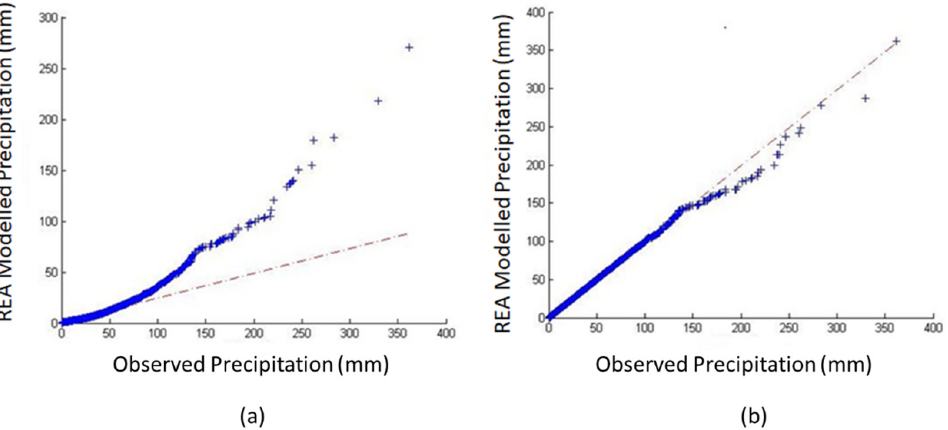
Figure 3. Quantile–Quantile (QQ) map of observed vs. REA modelled precipitation data ( a ) Before bias correction ( b ) After bias correction.